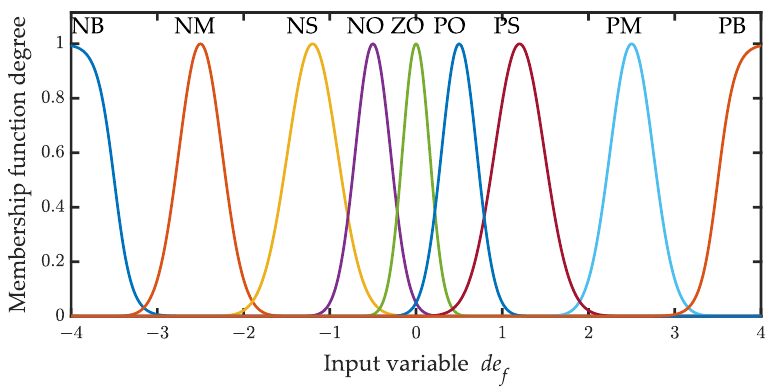
e . Figure 13. Membership function of input variable d e f f